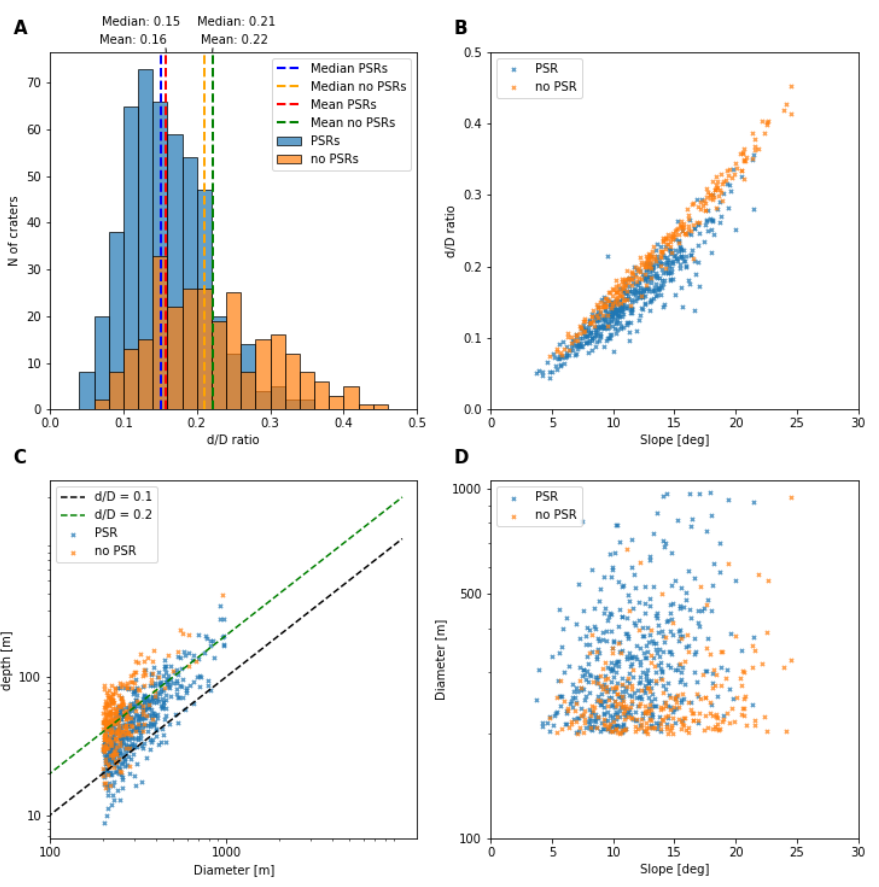
Figure 5. Comparison of craters containing PSRs and without PSRs. ( A ) Histogram of all d/D values measured within our RoI. Craters with PSRs in their interior are shown in blue with a peak around 0.16. Craters without PSRs are shown in orange with a peak at 0.22. ( B ) Average slopes and d/D ratio seem to show a strong correlation between wall slope and d/D ratio where the deepest craters have the steepest slopes. Craters with PSR tend to accumulate in the area with a low d/D ratio and low slope. ( C ) The average ratio for craters containing PSRs is approximately 0.1 which appears to be of an older age in comparison with the craters without PSRs. ( D ) Average slopes with respect to the diameter of the craters. Craters containing PSRs are normally characterized by low slope walls even for larger diameters, making them shallower. Craters with no PSRs are on average smaller in diameters but contain steeper